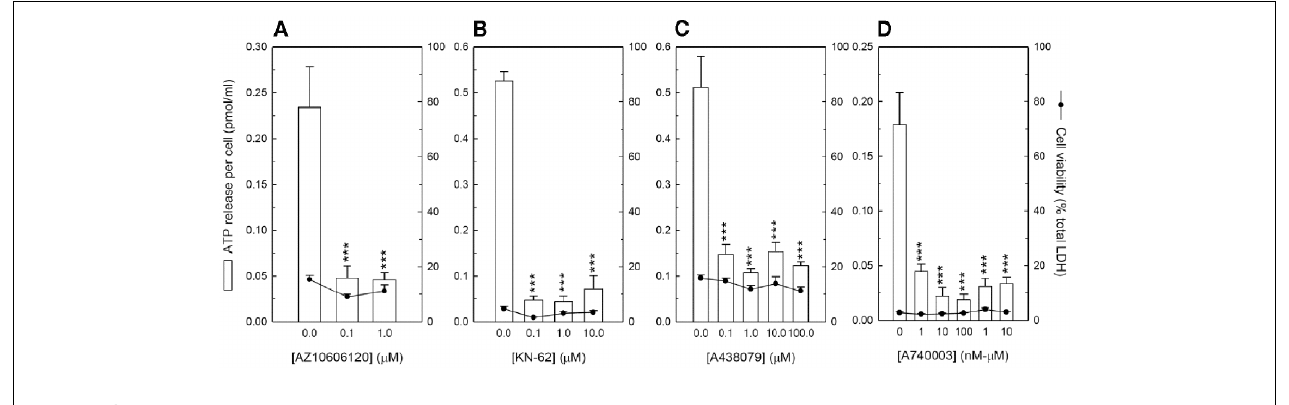
FIGURE 3 | P2X7 receptor antagonists inhibitATP release from osteoclasts. Cells were cultured on dentine disks for 7days before the effect of P2X7 receptor antagonists on ATP release from mature osteoclasts was investigated. (A) AZ10606120, (B) KN-62, (C) A438079, and (D) A740003 decreased ATP release by up to 80, 90, 80, and 85%,